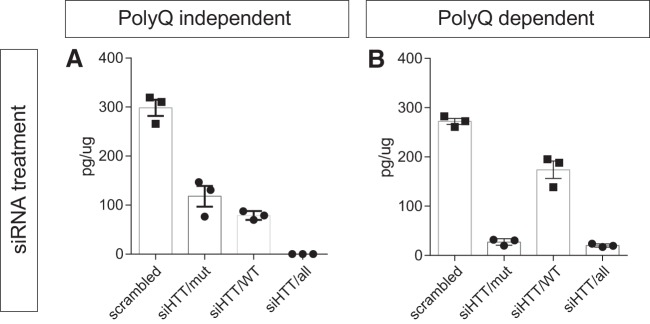
AlphaLISA signal changes on silencing of HTT. Neural stem cells generated from patient derived induced pluripotent stem cells were transfected with three different siRNAs targeting the mutant allele (siHTT/mut), the wild-type allele (siHTT/WT), or both (siHTT/all). Effects of HTT silencing were measured with the polyQ-independent (A) and dependent (B) assays. Data are presented as mean ± SEM.